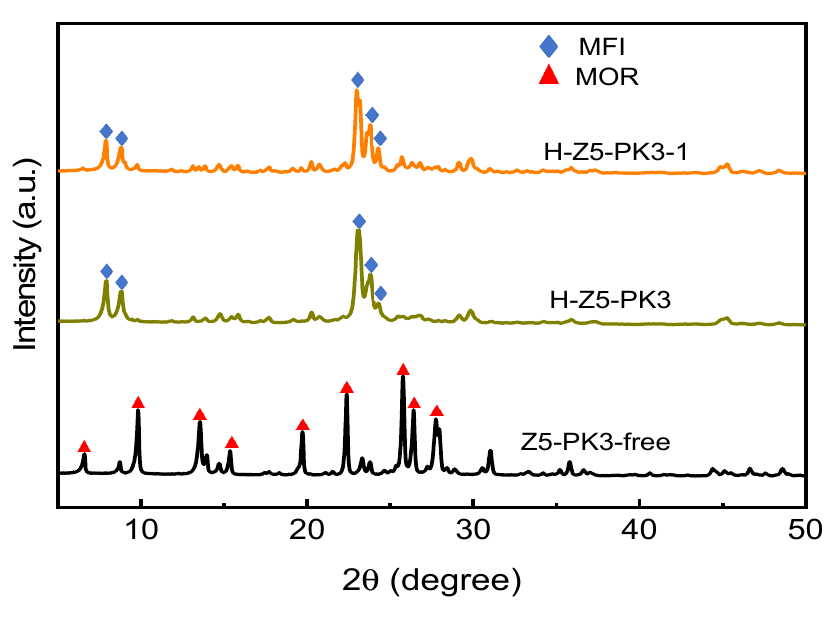
Figure 1. XRD patterns of the different samples.